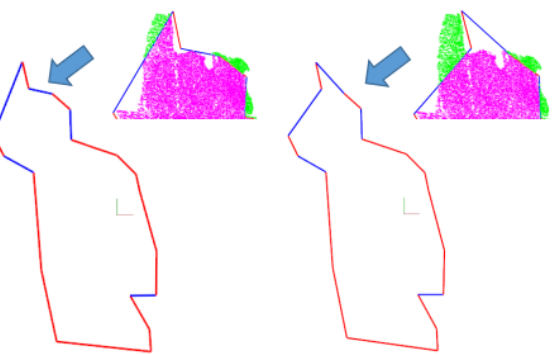
Figure 8. Two sets of feasible boundary sets. When the coverage is close, the boundary set that produces less redundant space will be selected. ( Left ): M =95.6%,C = 94.9%. ( Right ): M = 95.1%, C =